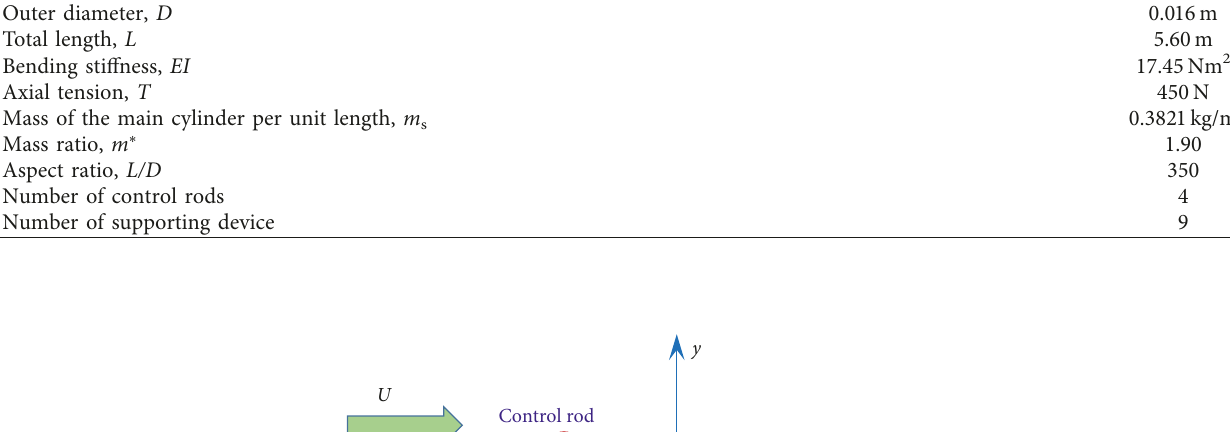
Table 1: Physical parameters of the main cylinder with control rods.